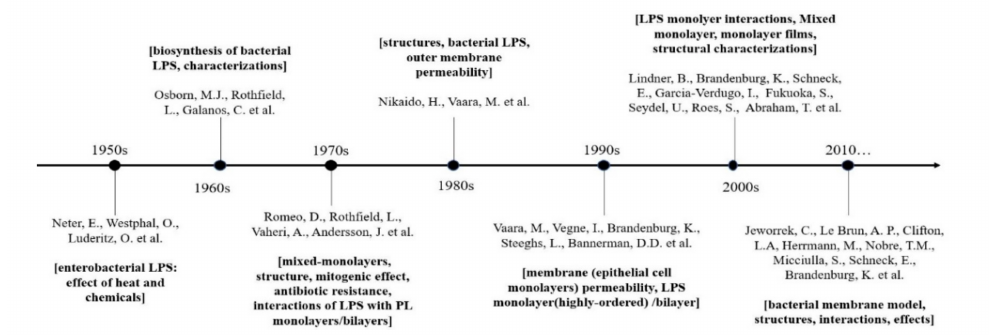
Figure 6. Timeline showing the events for studying LPS and its